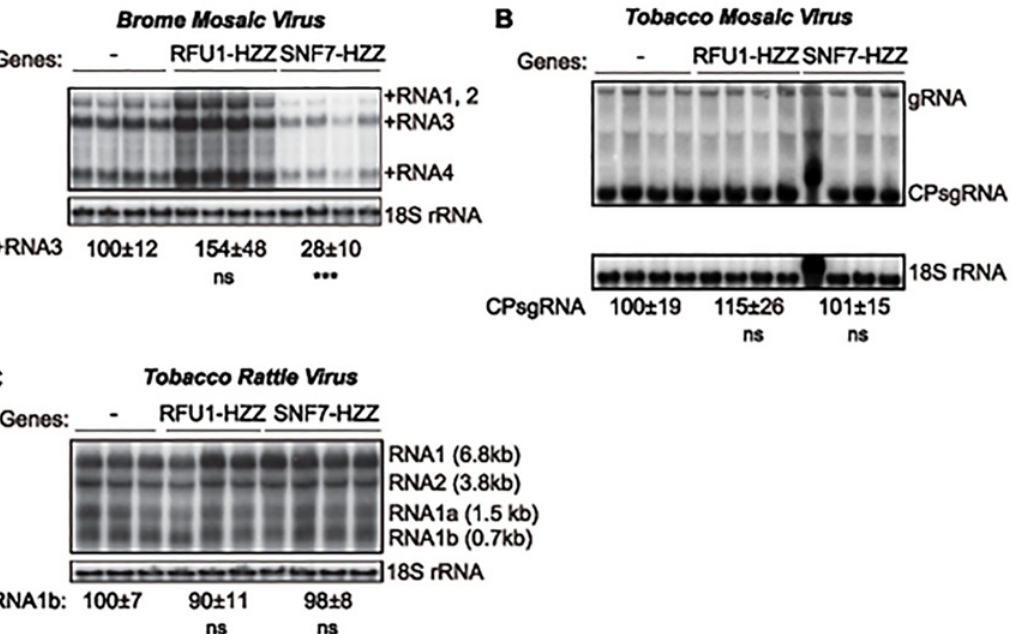
Fig 8. Dominant negative AtSNF7 – 2 inhibits BMV RNA accumulation in plants. Total RNA was extracted from N . benthamiana leaves that were co- infiltrated with Agrobacterium carrying plasmids launching an empty plasmid (-), RFU1-HZZ or AtSNF7 – 2 and either (A) BMV, (B) tobacco mosaic virus (TMV) or (C) tobacco rattle virus (TRV). Accumulation of genomic and subgenomic RNAs for each virus was measured by Northern blotting. Equal loading was verified by probing for 18S ribosomal RNA. Values represent the mean and standard deviation. *** p < 0.001, ns: not significant.